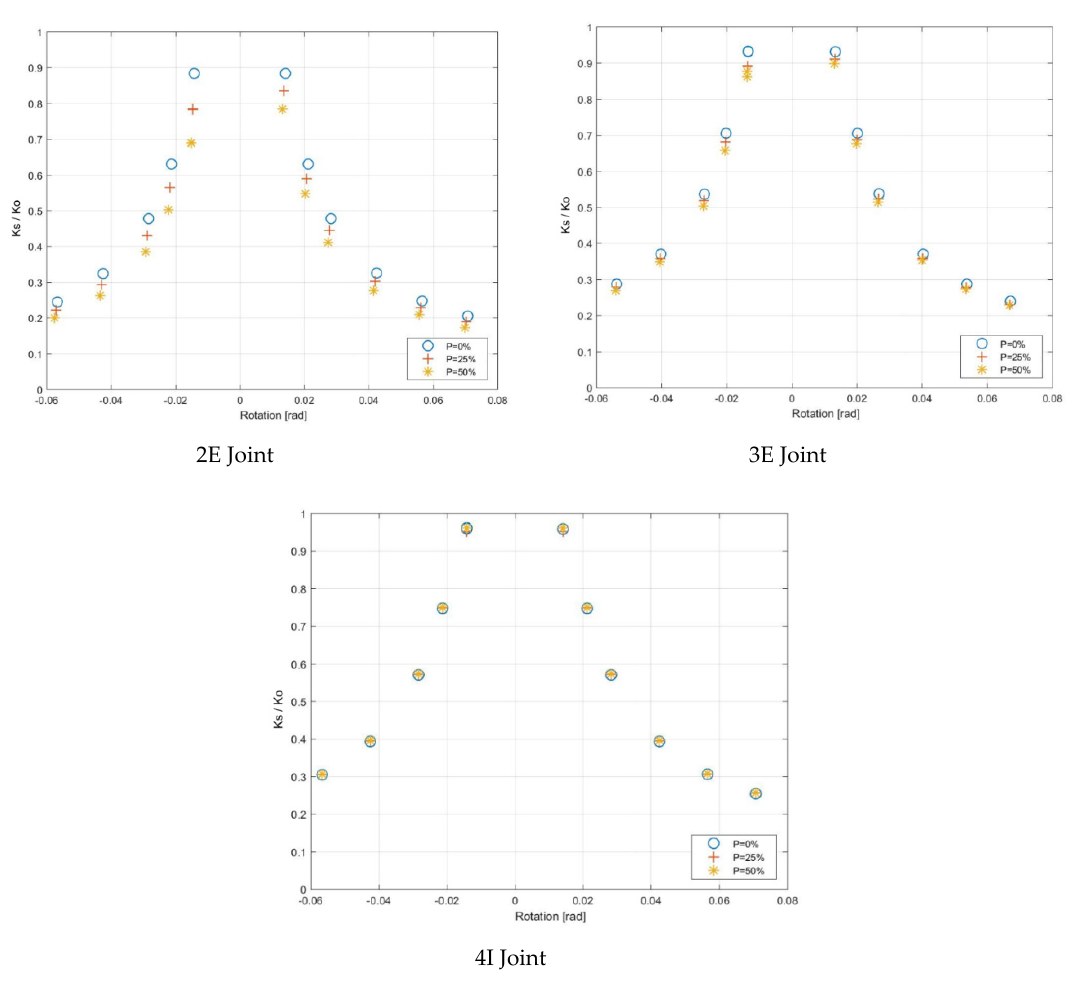
Figure 14. Summary of Secant Stiffness vs. Rotation according to equivalent load-displacement Method.